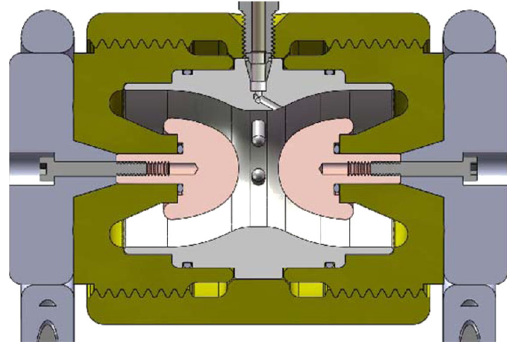
FIG. 7. (Color) Electric fields lines inside the Sandia-designed switch. The peak electric field on both the electrodes and the midplane is 190 kV = cm .